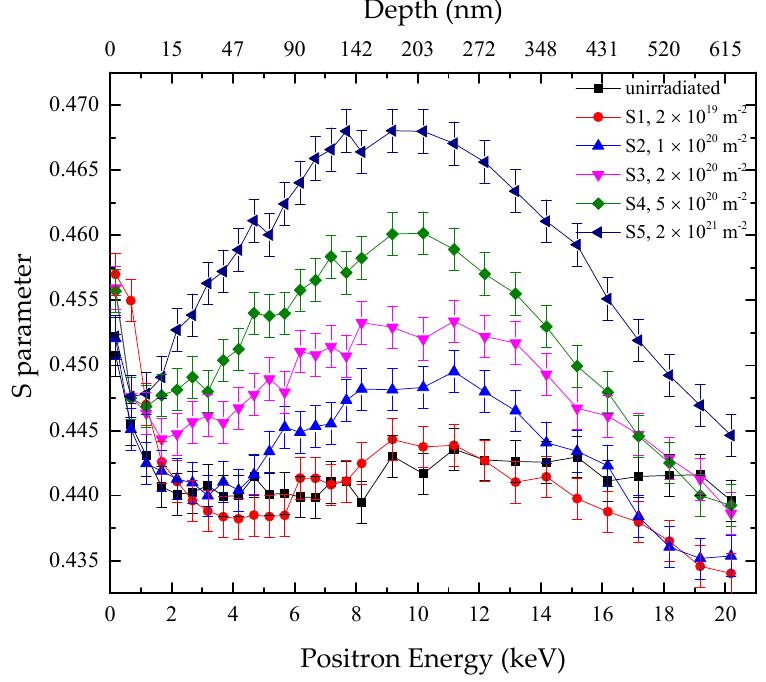
Figure 2. S–E curves for RAFM steels without irradiation and irradiated at 523 K to different fluences (2 × 10 19 , 1 × 10 20 , 2 × 10 20 , 5 × 10 20 , and 2 × 10 21 m − 2 ).